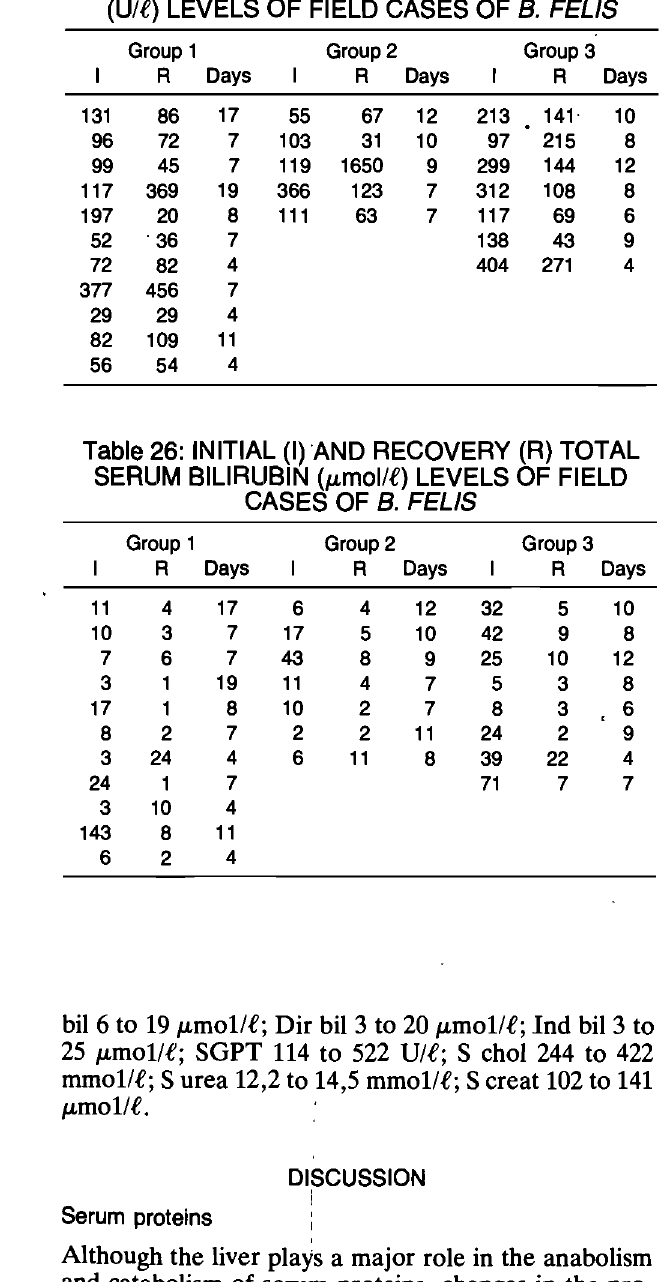
Table 25: INITIAL (I) AND RECOVERY (R) SGPT (U/e) LEVELS OF FIELD CASES OF B. FELIS